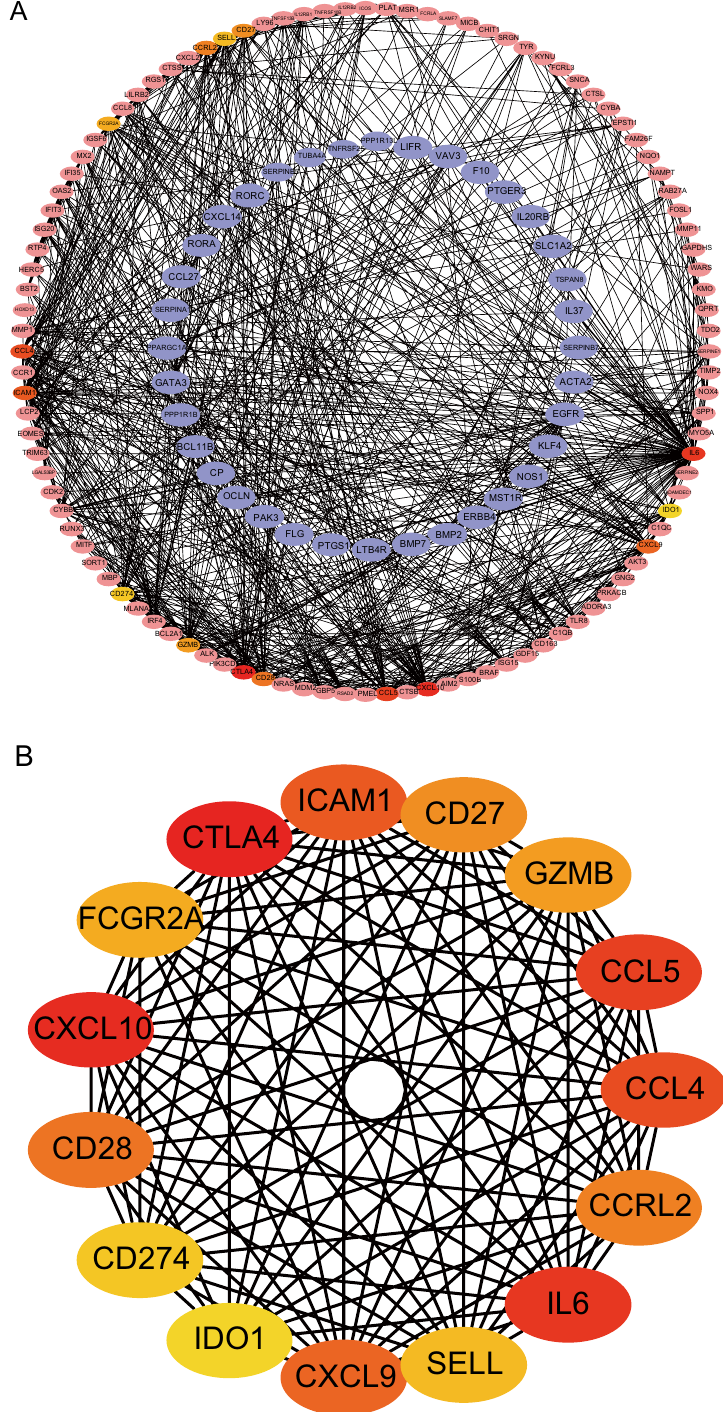
Figure 3. Construction of a PPI network and the identification of hub genes. ( A ) PPI network of DEGs. The outer circle represents upregulated genes, The outer circle represents downregulated genes, and the darker the color, the stronger the connection between the gene and other genes. ( B ) Top 15 DEGs obtained by MCC of cytohubba. DEG differentially expressed gene, PPI protein–protein interaction, MCC maximal clique